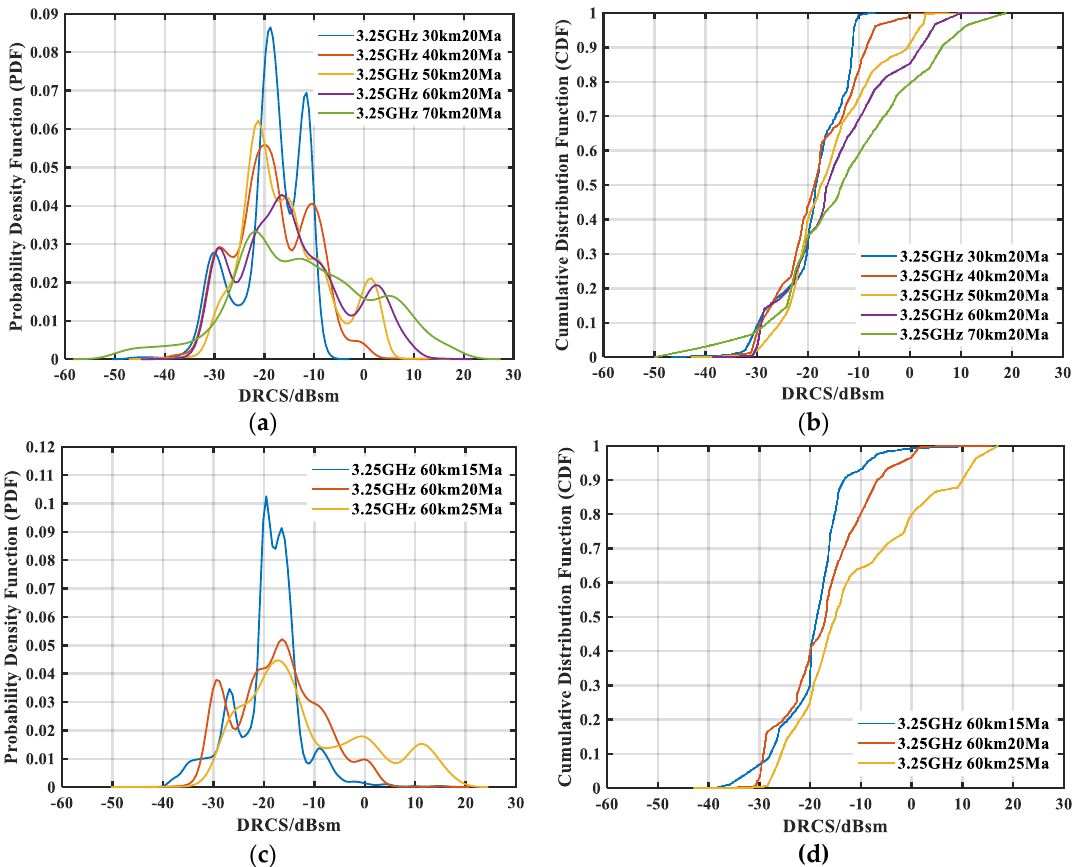
Figure 7. PDF and CDF distributions of DRCS time series for hypersonic vehicles under di ff erent flying conditions. Incident EM wave frequency f = 3.25 GHz: ( a ) PDF: H x = 30 km, 40 km, 50 km, 60 km and 70 km, v = 20 Mach; ( b ) CDF: H x = 30 km, 40 km, 50 km, 60 km and 70 km, v = 20 Mach; ( c ) PDF: H x = 60 km, v = 15 Mach, 20 Mach, 25 Mach; and ( d ) CDF :H x = 60 km, v = 15 Mach,20 Mach,25